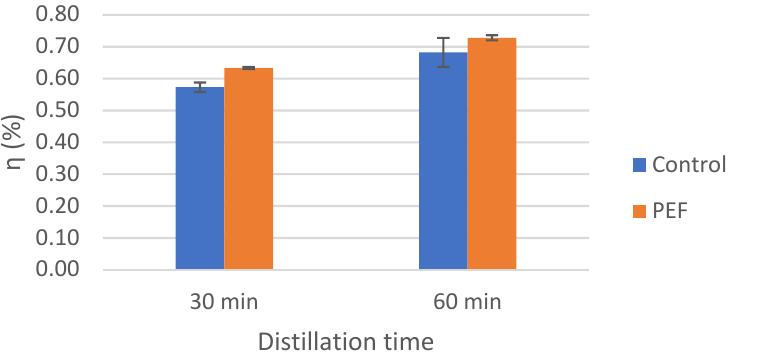
Figure 4. Results of yield of rosemary EO extracted with (PEF) and without PEF application (Control),